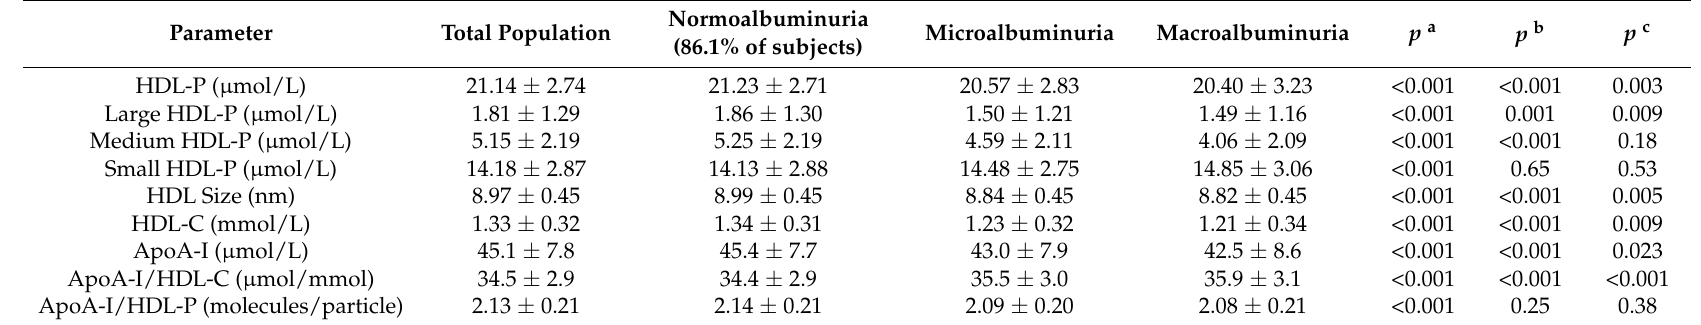
Table 4. NMR-derived biomarker levels (mean ± SD) in the study population at second screening round stratified according to 24 h urinary albumin excretion (UAE) as: normoalbuminuria <30 mg/24 h, microalbuminuria between 30 and 300 mg/24 h, and macroalbuminuria >300 mg/24 h. Ranges of HDL particle diameters